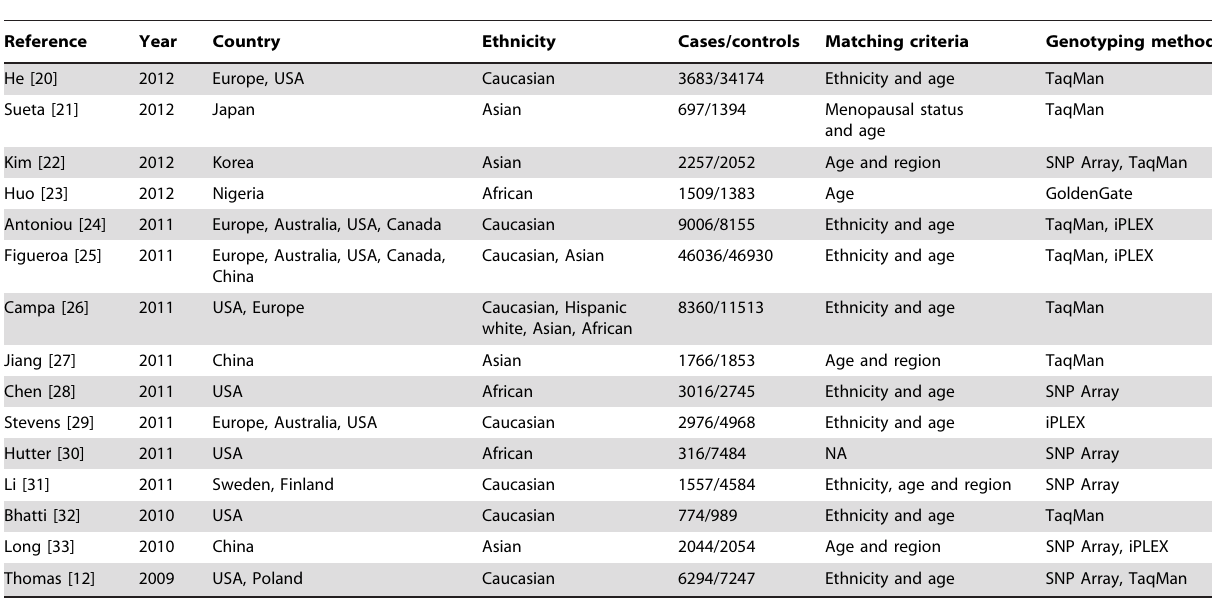
Table 1. Characteristics of studies included in a meta-analysis of the association between 1p11-rs11249433 and breast cancer.